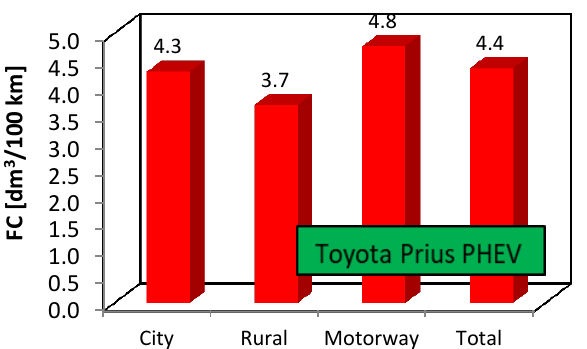
Fig. 10. Proportion of the drive with the combustion engine switched off Fig. 7. Fuel consumption in the subsequent phases of the RDE test (Toyota (ZEV) in relation to the duration of the individual phases of the RDE test Prius PHEV) [4] (Toyota Prius PHEV) [9]